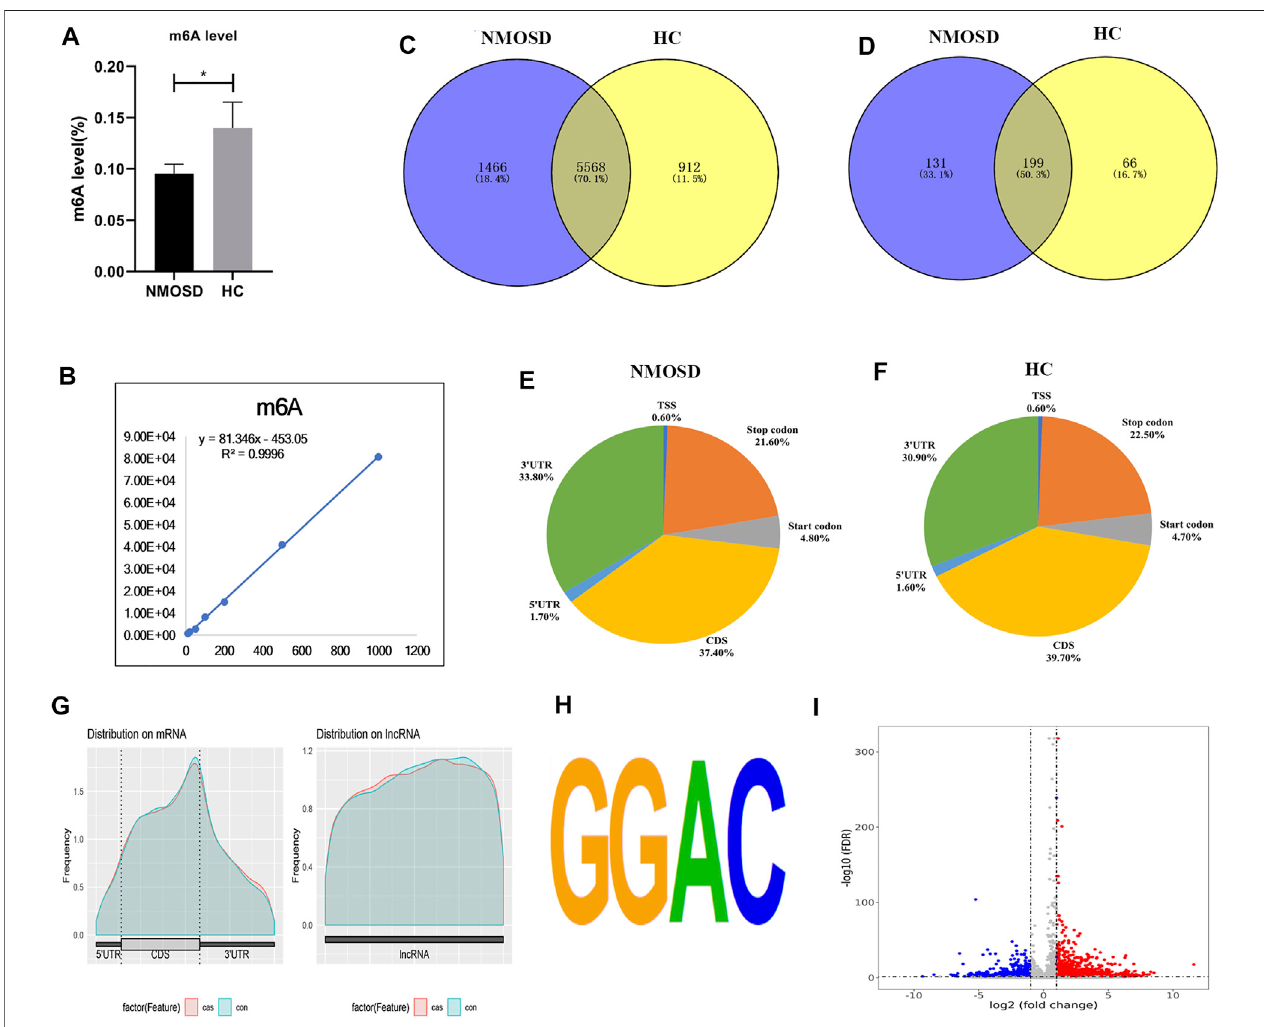
FIGURE 1 | Overview of N 6 -methyladenosine methylation in NMOSD patients and HCs. (A) m 6 A levels in NMOSD and HCs,* p < 0.05,Student ’ s t -test. (B) R 2 was greater than 0.99, indicating that the linear relationship of the standard curve is good. (C) Venn diagram showing the overlap of m 6 A peaks with mRNA in NMOSD patientsandHCs. (D) Weused aVenndiagramtodepicttheoverlapofm 6 ApeakswithlncRNAs inNMOSDandHCs. (E) Weused piechartstoshow theaccumulation of m 6 A peaks along transcripts in NMOSD. (F) We used pie charts to display the accumulation of m 6 A peaks along transcripts in HCs. (G) Metagene plot of peak distributionin RNAstructures (NMOSD andHCs). (H) The consensus motif form 6 Amodi fi cation is “ GGAC ” . (I) Volcano map ofdifferential m 6 Amodi fi cation. Diff.log2 FC < 0 indicates hypomethylation, indicating that the site was demethylated under treatment conditions; Diff.log2 FC > 0 indicates hypermethylation, indicating hypermethylationofthissiteundertreatmentconditions.Diff.lg.fdr:log10(FDR)ofdifferentialmethylationanalysisisthelog10conversionvalueoftheFDRvalueobtained from the differential analysis. Red indicates hypermethylation, and blue indicates demethylation. Red and blue represent geneswith amore than 2-fold difference in m 6 A modi fi